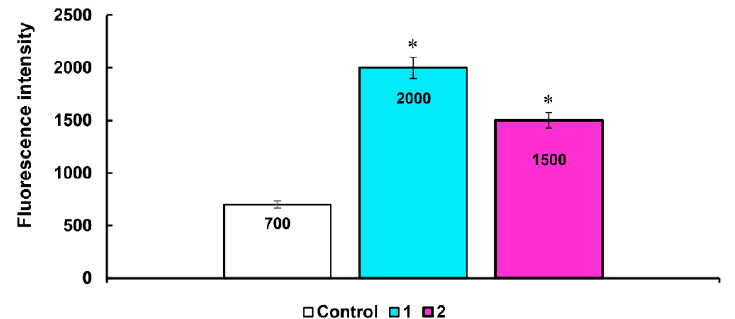
Figure 6. Induction of ROS production by lead compound 2a . 1– 2a at concentration IC 50 /2 (12.5 µ M); 2– 2a at concentration IC 50 (25 µ M); ( ∗ ) p < 0.05 compared to control.